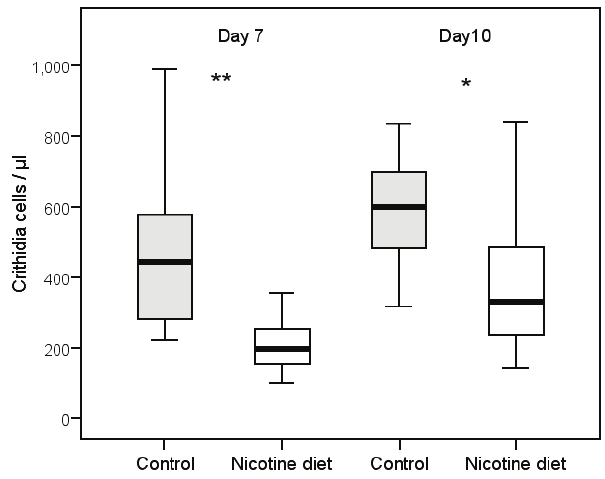
Figure 2. Intensity of C. bombi infections in bumblebees inoculated with pathogens previously exposed to nicotine for two hours (Experimental bees, n = 20) or to a control sucrose diet (Control bees, n = 20). Faeces were checked after 7 days and 10 days post inoculation. Box plots show medians, 25 th and 75 th percentiles ( P =